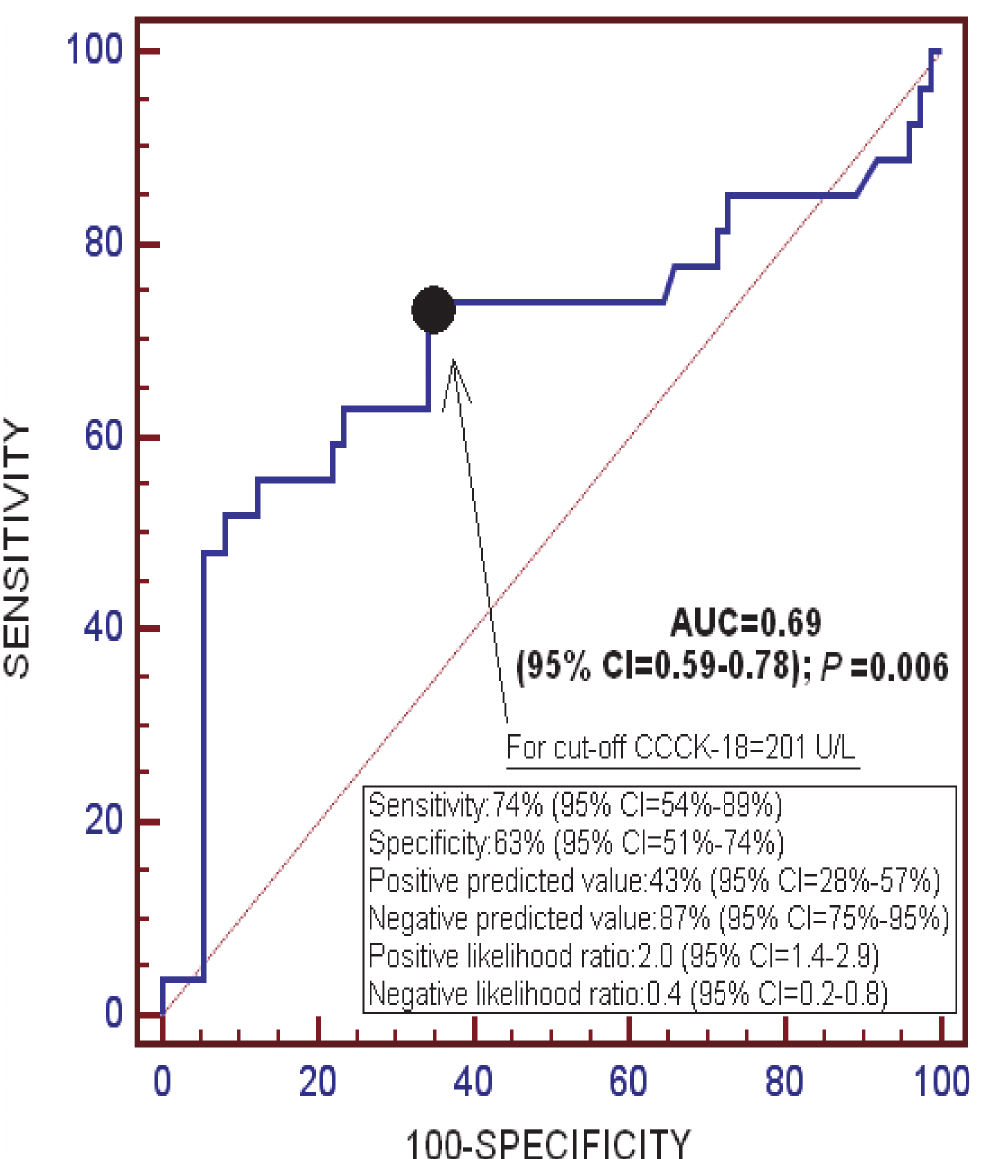
Fig 1. Receiver operating characteristic analysis using serum caspase-cleaved cytokeratin (CCCK)-18 levels as a predictor of mortality at 30 days.